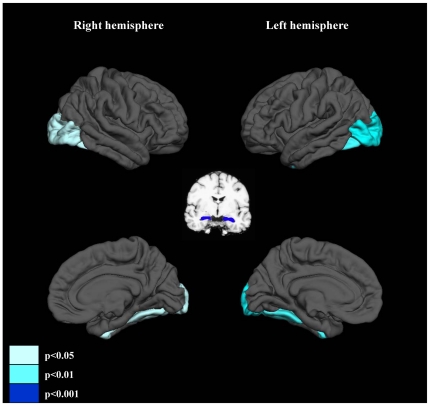
ROIs for which the volumes were significantly reduced in schizophrenia patients compared with those of healthy subjects.ROIs were differentially colored according to the p values of the post hoc tests.